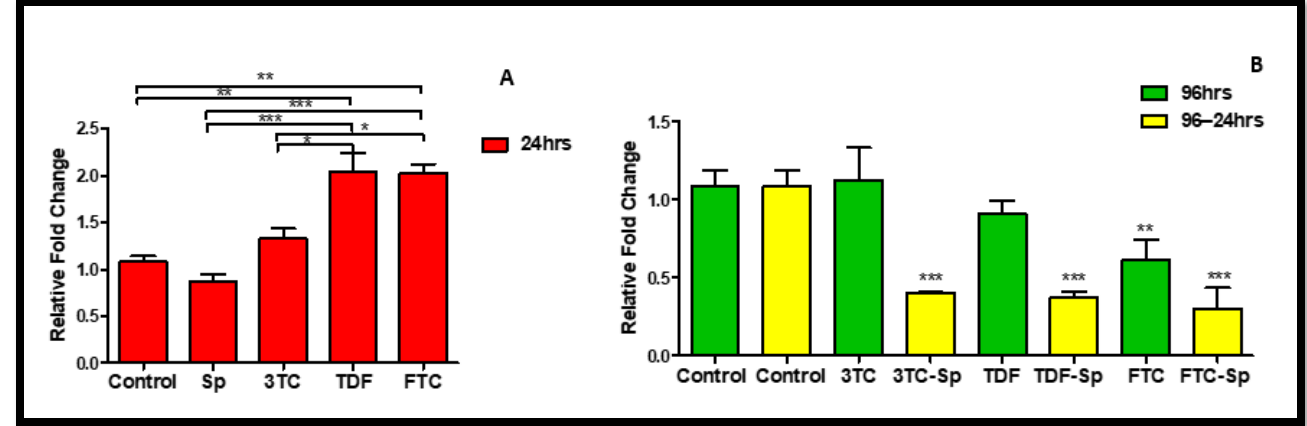
Figure 1. Effects of SP and HAART (3TC, TDF, and FTC) on Akt mRNA levels. Akt mRNA levels after exposure of HepG2 cells to ( A ): SP and HAART for 24 h, ( B ): HAART (96 h), and HAART (96 h) followed by SP (24 h); * p < 0.05, ** p < 0.005, *** p < 0.0001.